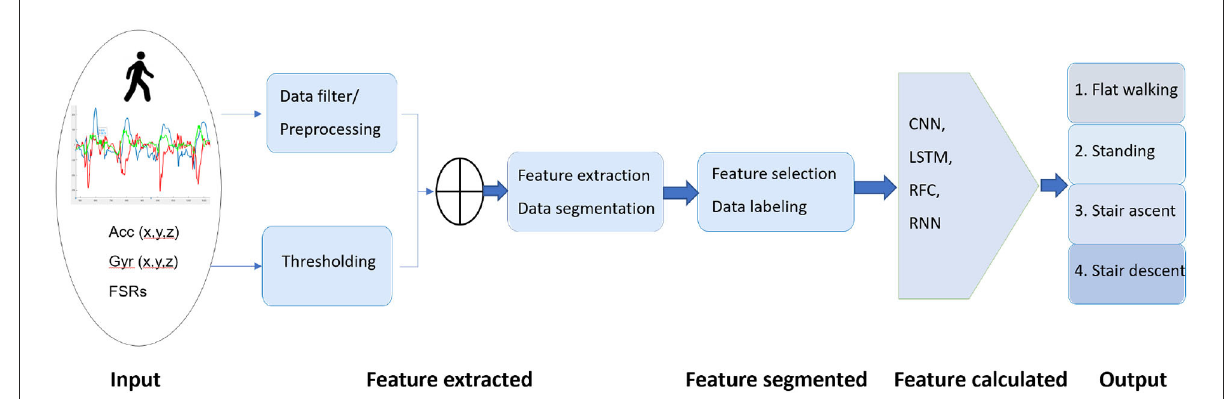
FIGURE3 The structure of the overall random forest classifier (RFC). The inputs to the network are created by six signal channels of one IMU, and the outputs are classified into four walking modes: LW, ST, and SA/SD.